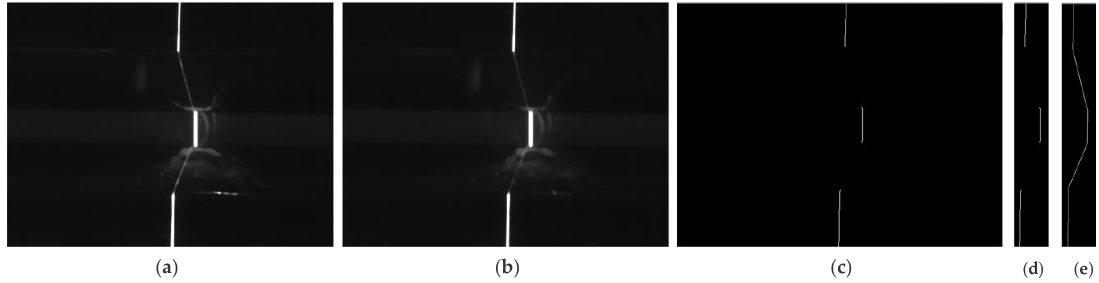
Figure 8. ( a , b ) Image noise processing result of Figure 4e, ( c ) laser curve, ( d ) region of interest (ROI), and ( e ) laser curve fitting.